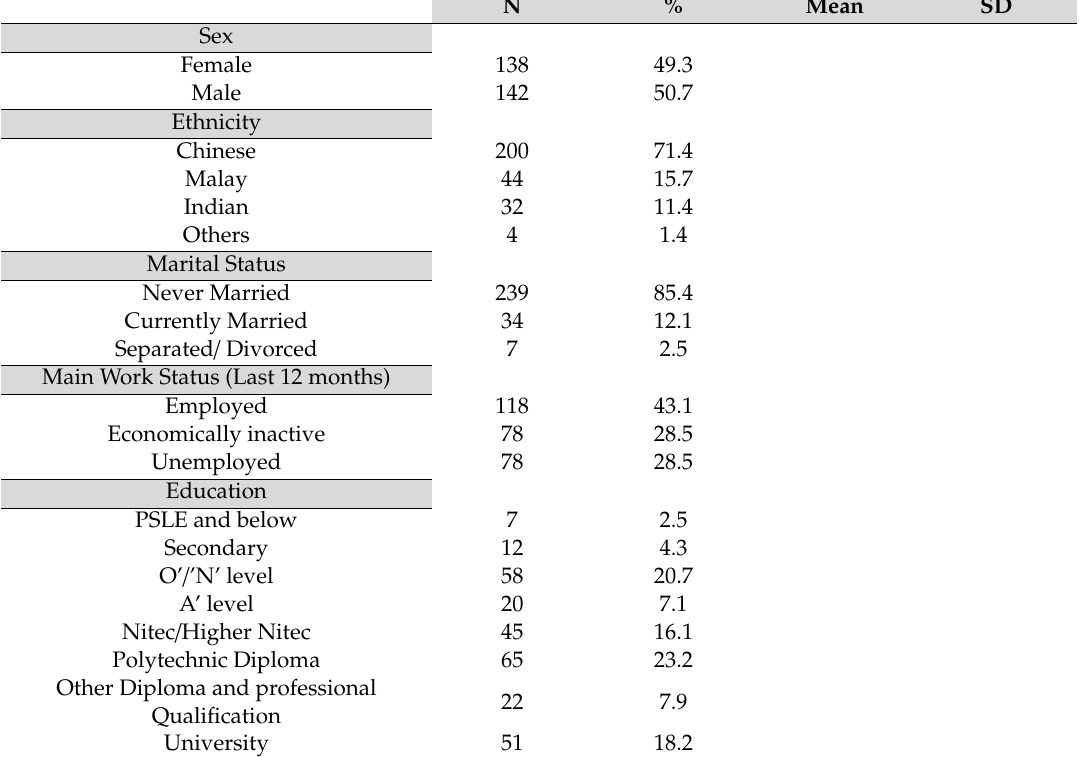
Table 1. Socio-demographic and clinical characteristics of participants (n =